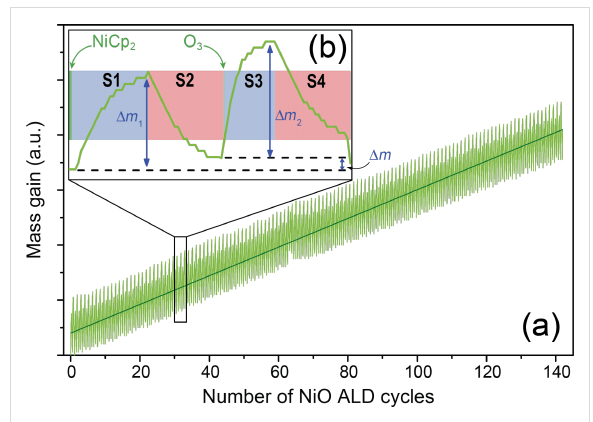
Figure 2: (a) In situ QCM measurement of the NiO mass gain during the ALD process. (b) Enlarged view of the mass gain for one ALD cycle. Δ m corresponds to the net mass increase after the ALD